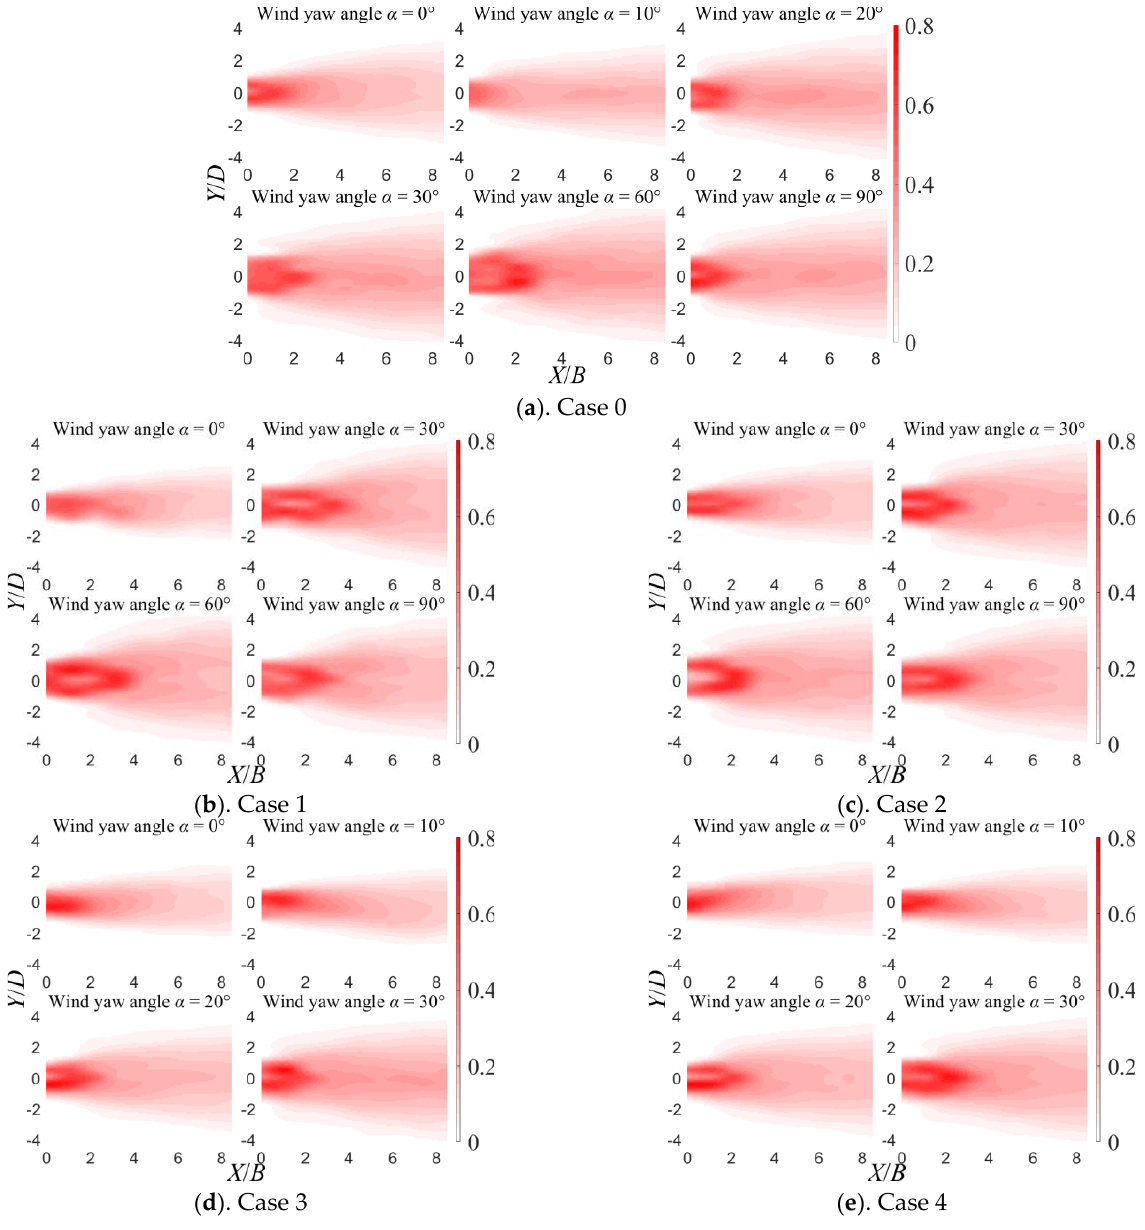
Figure 7. Turbulence intensity distribution of tower wake.